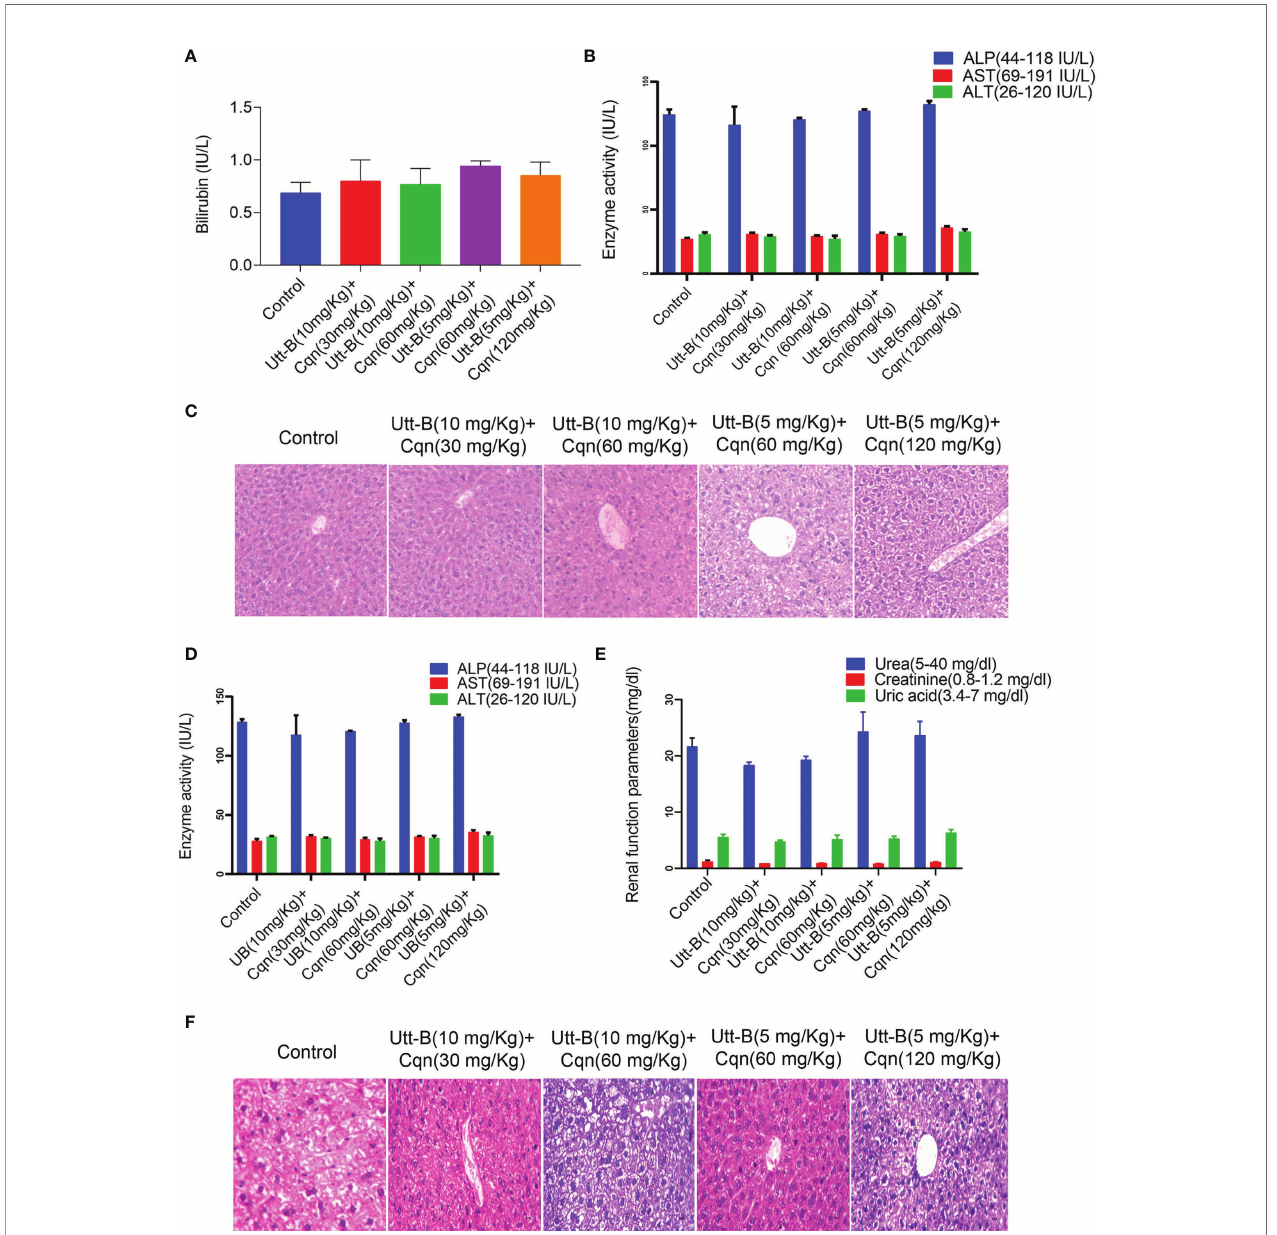
FIGURE 5 | Combination of Cqn and Utt-B ispharmacologically safein Swiss Albino mice. (A, B) Acute toxicity analysis of Bilirubin andliver enzymes such as AST, ALT, andALP values show allthe combinationsare within the range. (C) Hematoxylin and eosin staining in liver tissues of controland treatment groups ofacute toxicity study (D, E) Liver and renal function parameters of Sub-chronic toxicity analysisofthe combination (F) Histopathologyofliver tissues fromsub-chronic toxicity